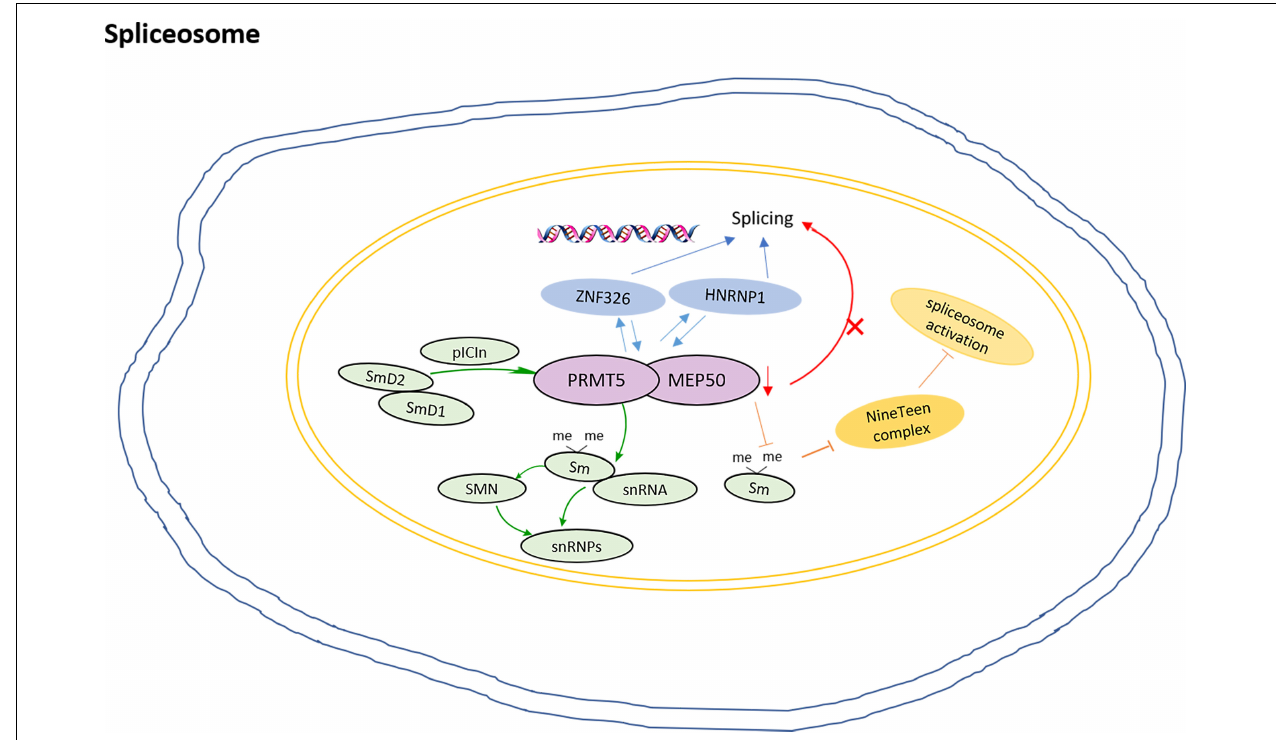
FIGURE 3 | The model for PRMT5 roles in regulation of spliceosome. pICln recruits Sm proteins into the PRMT5 complex for methylation, then the methylated Sm proteins are loaded onto snRNAs to form snRNPs; The formation of Sm D2/D1 dimers and their binding to pICln ensures their release and subsequent delivery to the PRMT5 complex; The loss of Sm protein SDMA prevents the recruitment of the NineTeen complex and the initiation of spliceosome activation; ZNF326 interacts with PRMT5 and WDR77, and HNRNPH1, the loss of PRMT5 and WDR77 leads to the overall defect of alternative